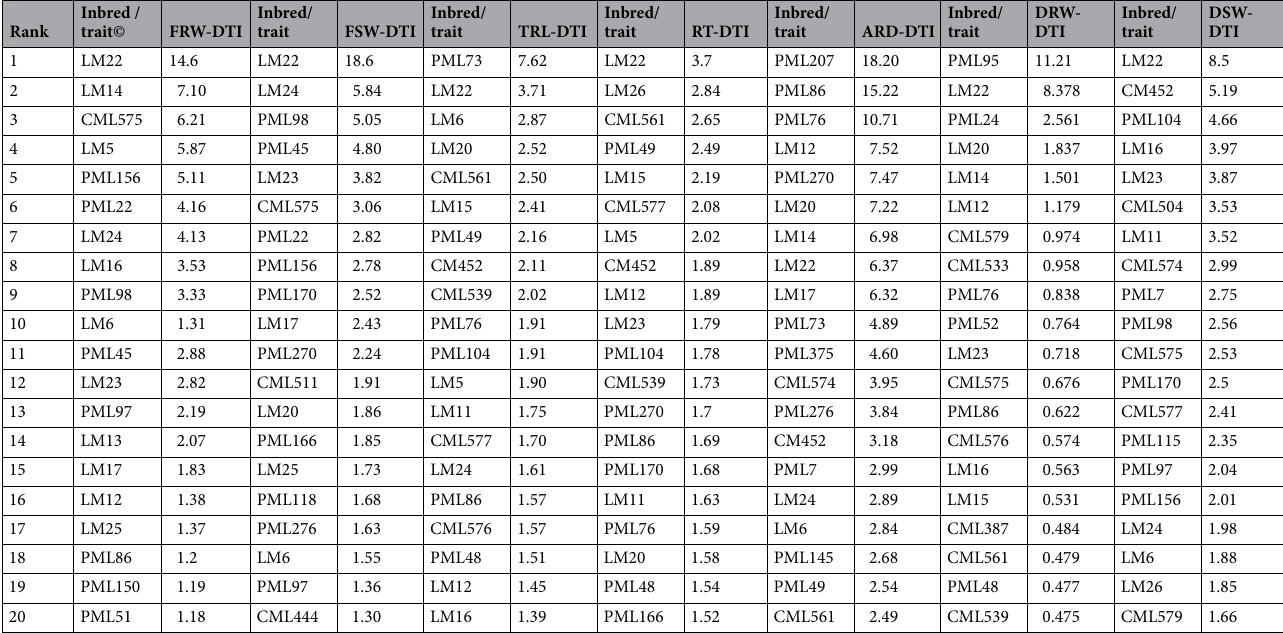
Table 5. Trait based drought tolerant index (DTI) ranking of top twenty inbred lines of maize. ©FRW (g) fresh root weight, FSW (g) fresh shoot weight, DRW (g) dry root weight, DSW (g) dry shoot weight, TRL (cm) total root length, RT number of root tips, ARD (mm) average root